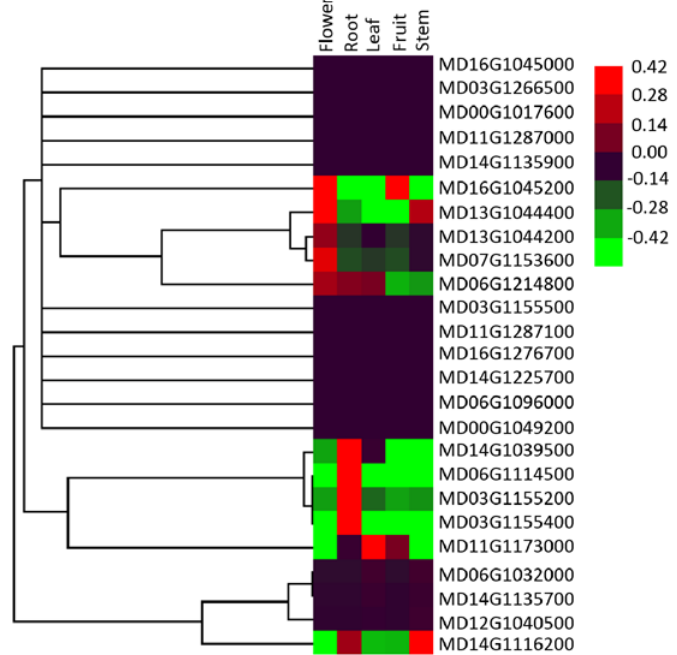
Figure 6. Expression profiles of apple ALMTs in five kinds of tissue, full-bloom flower (Flower), Root, mature leaf (Leaf), ripening fruit (Fruit), and Stem. Heat map was constructed based on relative expression levels. Different colors represent different expression level, with red representing the highest value of gene expression.